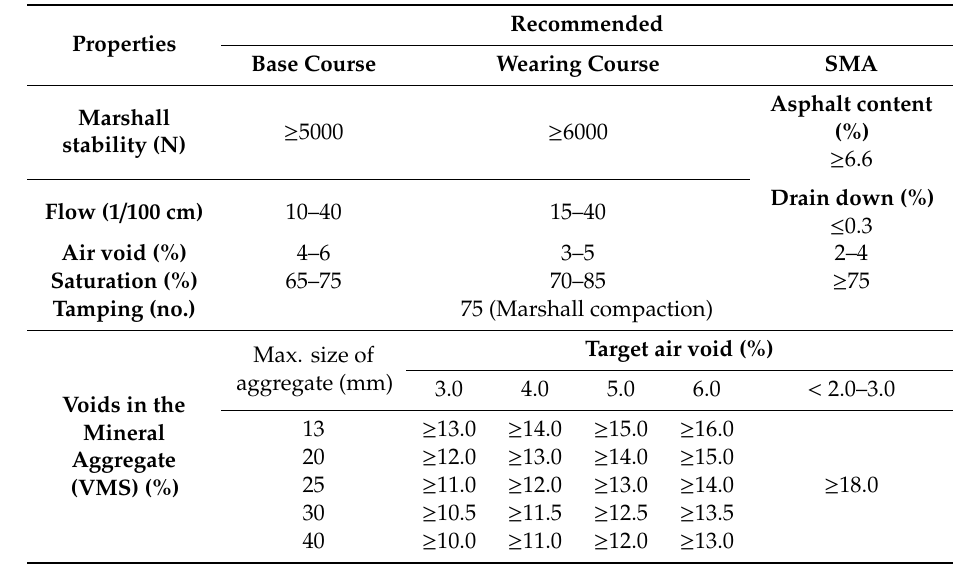
Table 2. Asphalt mix design